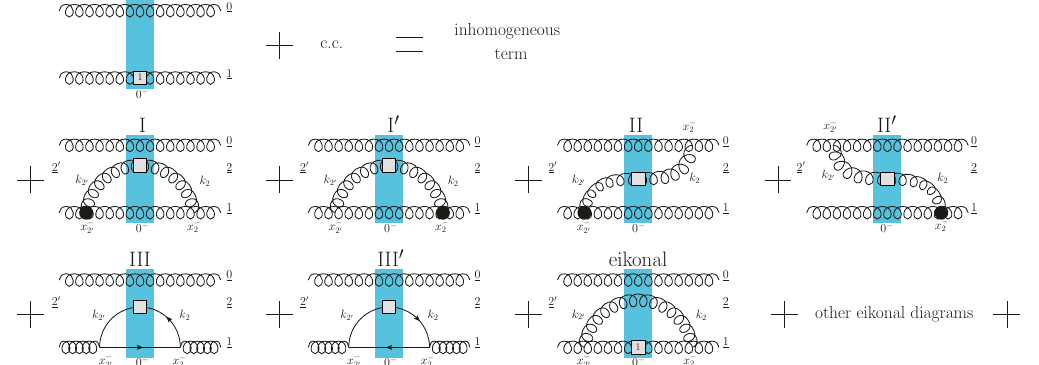
. 10 only. The black circle 1